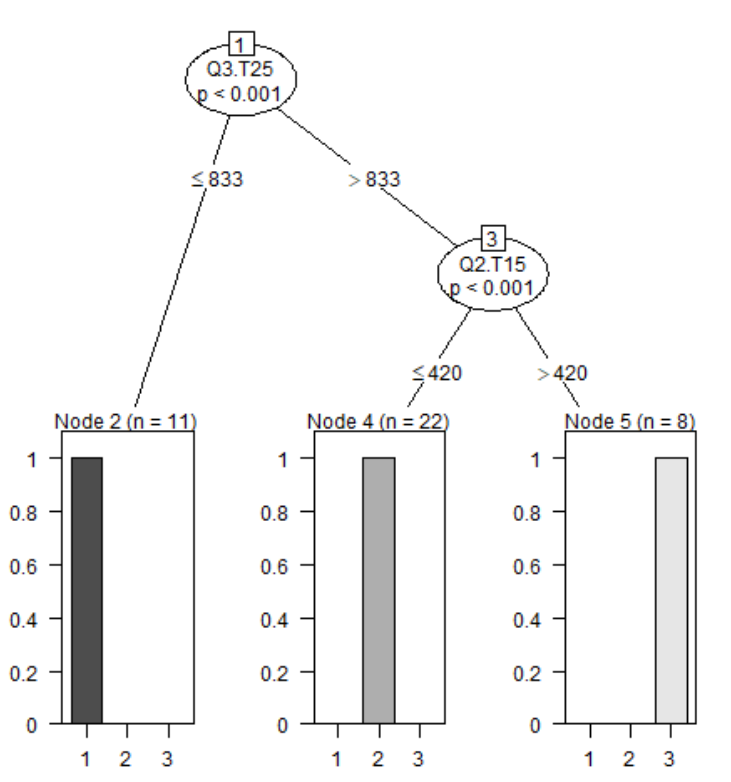
Figure 6. Decision tree model separating 41 cultivars into three categories (clusters) based on the third quartile at 25 °C (Q3.T25) and second quartile at 15 °C (Q2.T15).